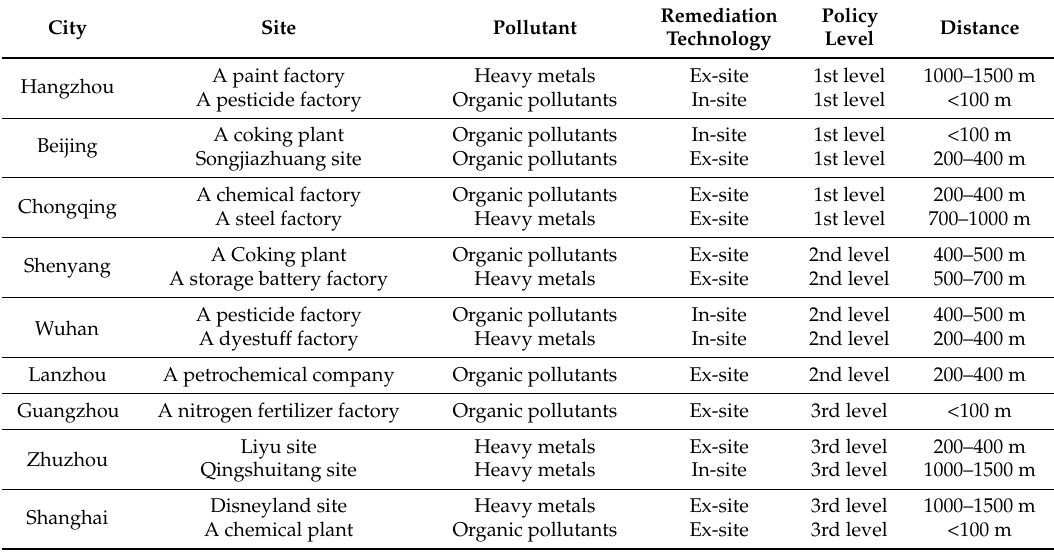
Table 8. Basic information on investigated sites.